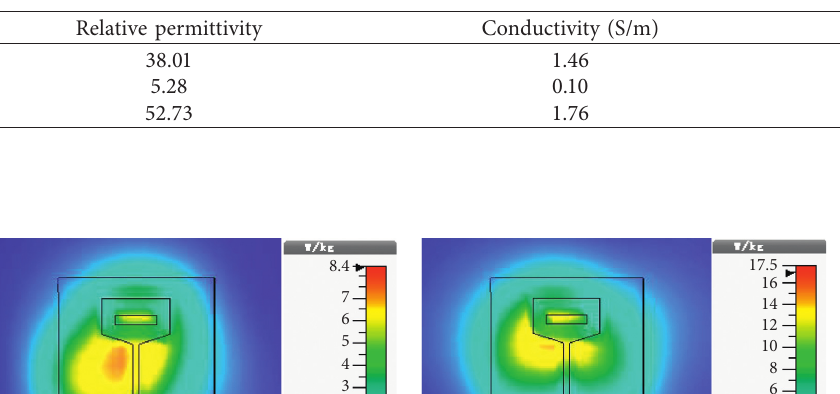
Figure 9: The gain and efficiency of the antenna. Table 1: Electromagnetic parameters of human tissues.